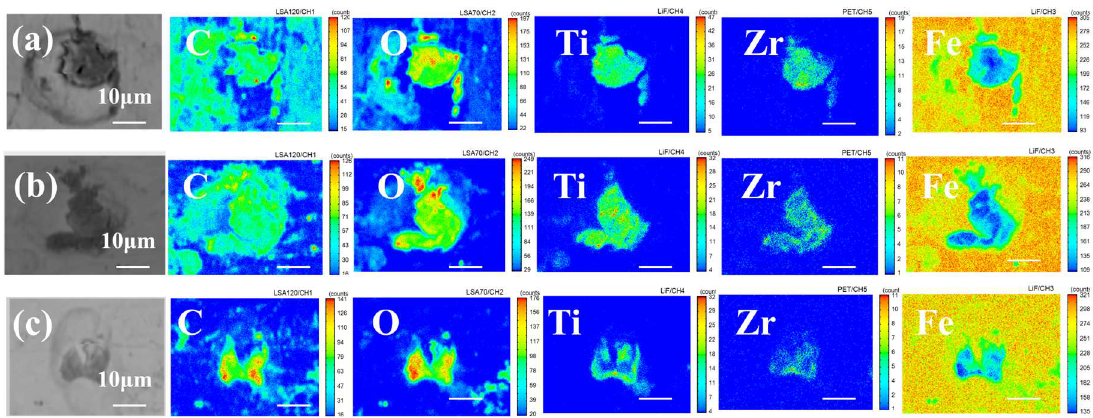
Figure 9. Results of EMPA of galvanized steel with synchronous chemical conversion at different times: ( a ) at 100 s, ( b ) at 120 s, ( c ) at 140